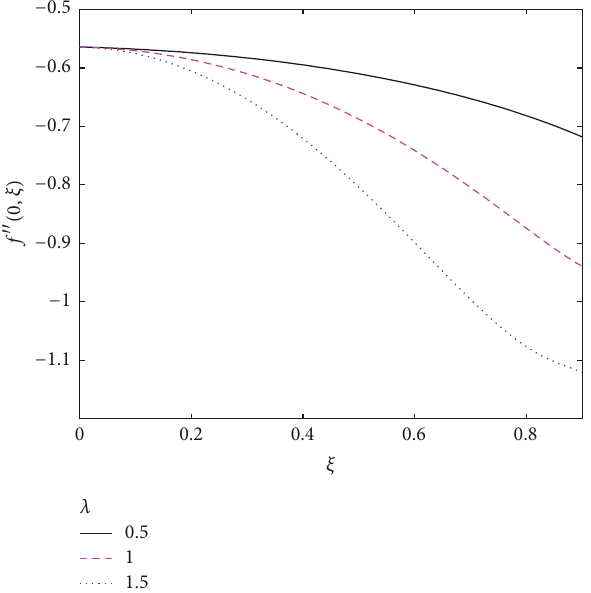
Figure 9: Effect of 𝜆 on 𝑓 󸀠󸀠 (0,𝜉) ( 𝜎 = 𝛾 = 0.5, Pr = 3, Sc = 2, ℏ = −0.5 ).